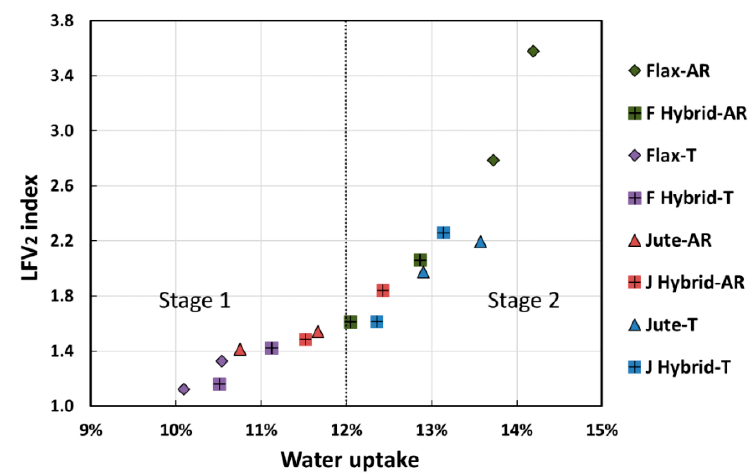
Figure 10. Relationship between moisture content and the variation of second loss factor peak (LFV 2